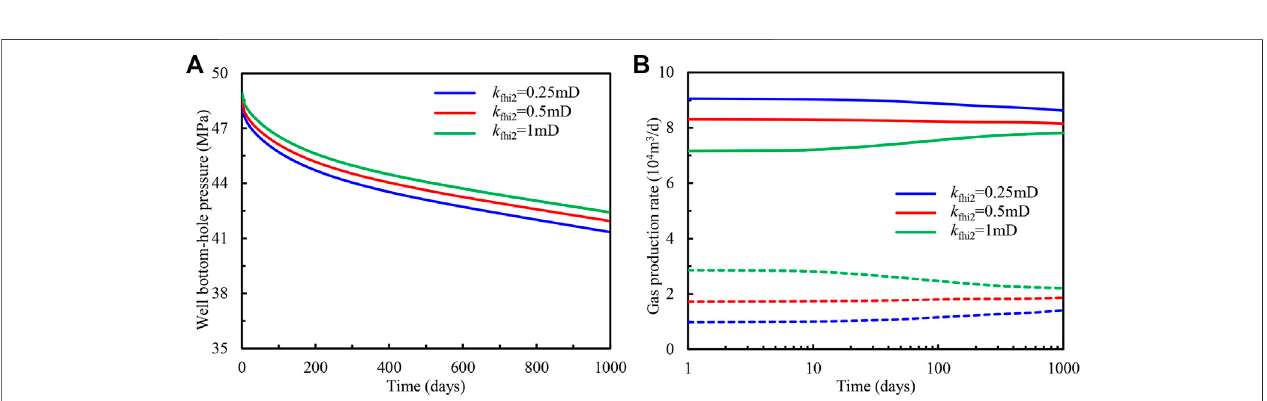
FIGURE 8 | In fl uence of horizontal permeability for natural fracture in the second layer on (A) bottom-hole fl owing pressure and (B) gas production of individual formation.